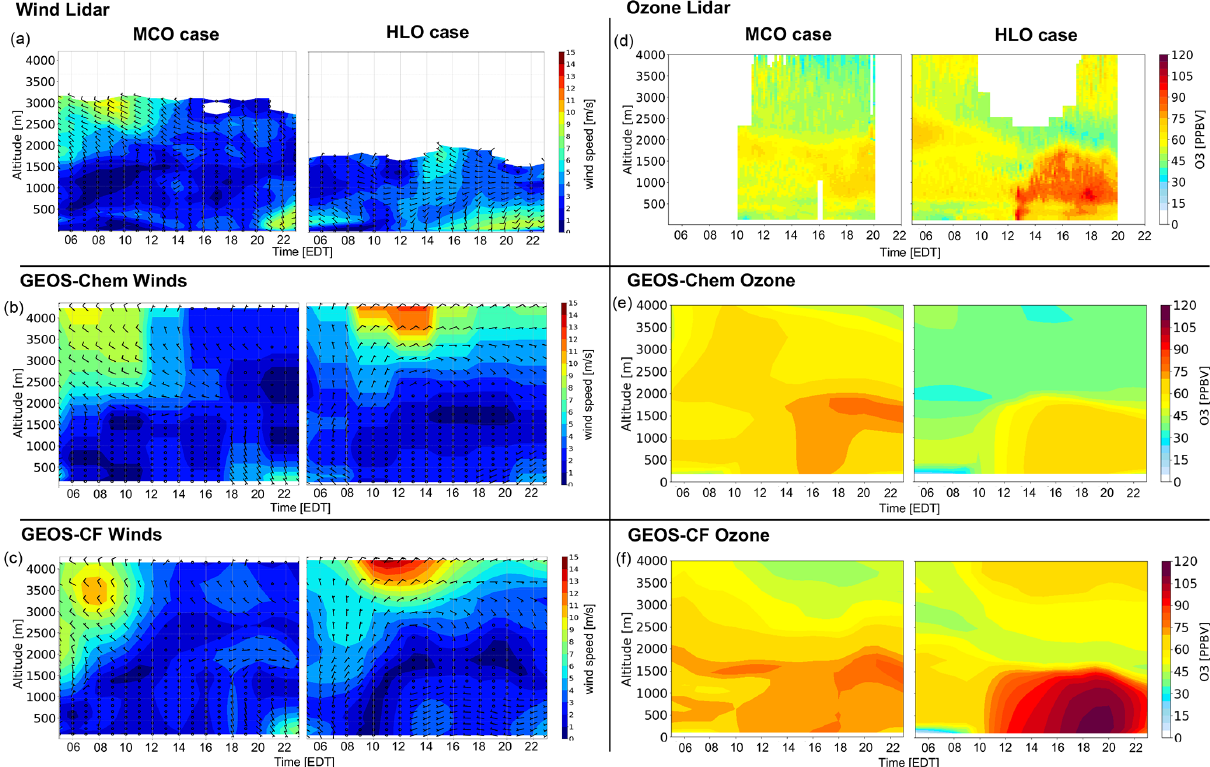
Figure 8. Profile curtains of wind speed/direction (a–c) and O 3 (d–f) from the lidar (a, d) , GEOS-Chem (b, d) , and GEOS-CF (c, f) . Results from OWLETS-2 at HMI. Wind direction is depicted by wind barbs. The white spaces indicate missing data for both the (a) wind and (d) O 3 lidar curtain